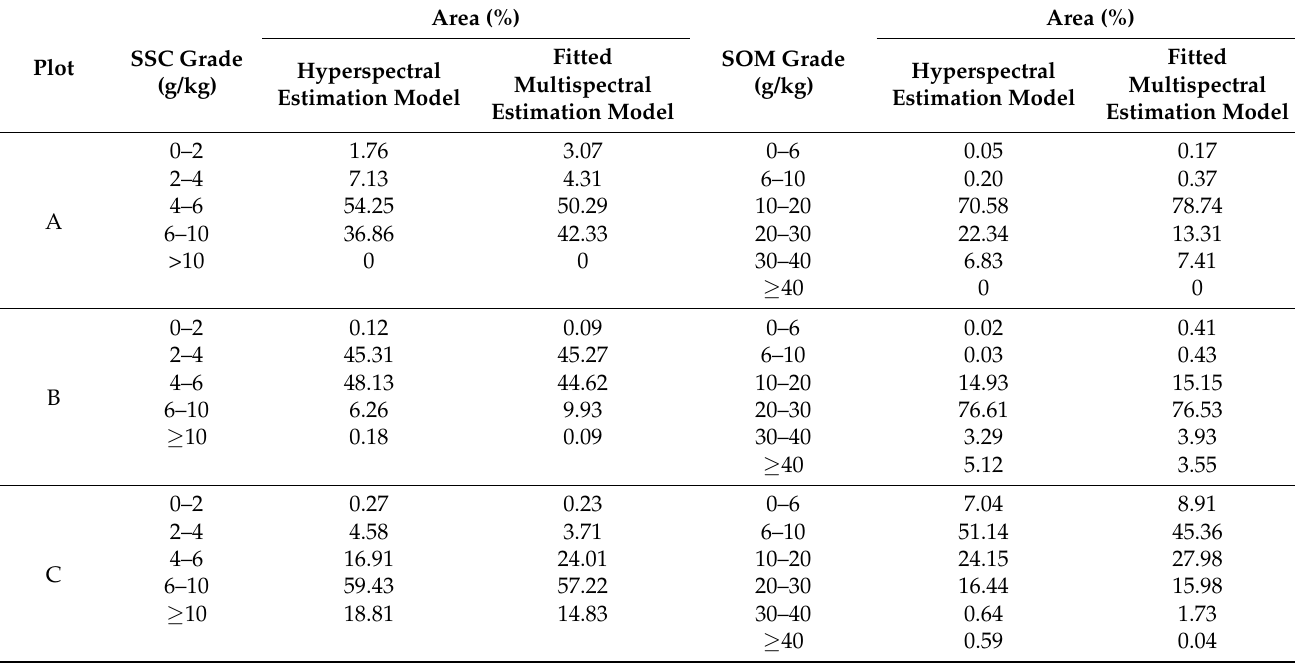
Table 8. Areal distribution of SSC and SOM in the three test plots.